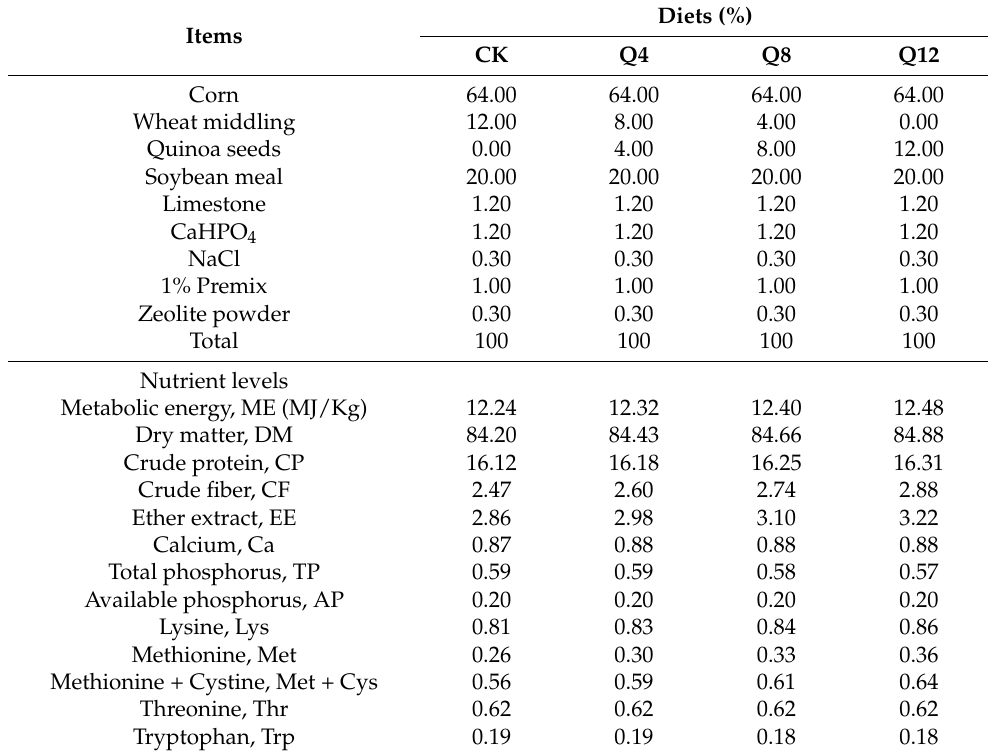
Table 1. Composition and nutrient level of experimental diets (dry matter basis).